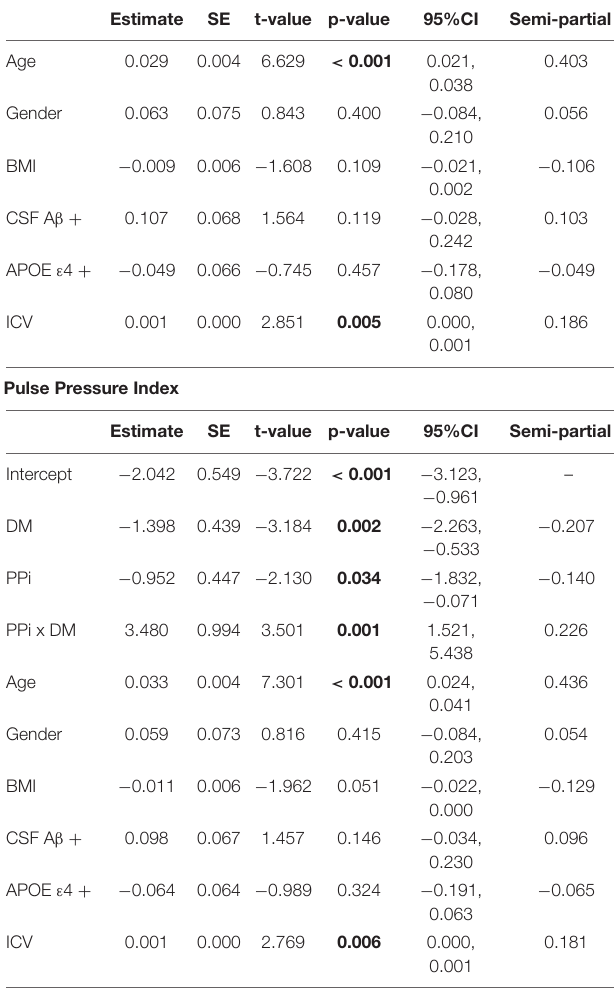
TABLE 3 | Final Multiple Linear Regression Models for MCI Older Adults. Systolic Blood Pressure Estimate SE t-value